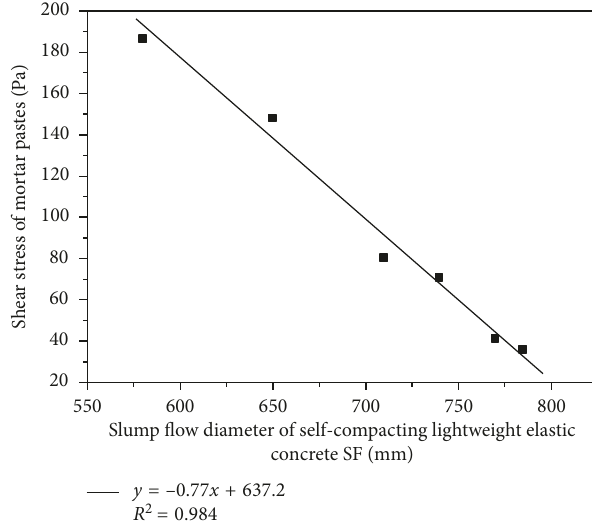
Figure 19: Relationship between slump flow of SCRLC and shear stress of corresponding mortar